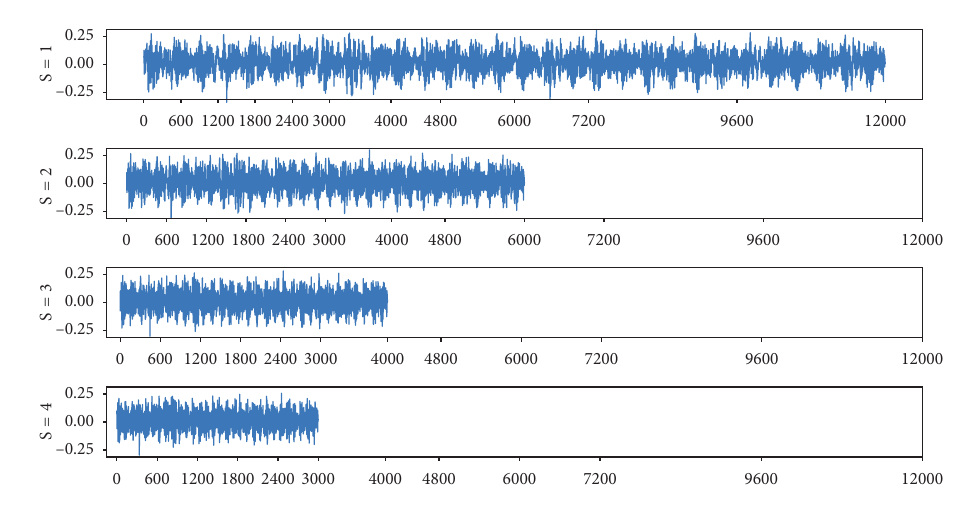
Figure 7: Multiscale processing of